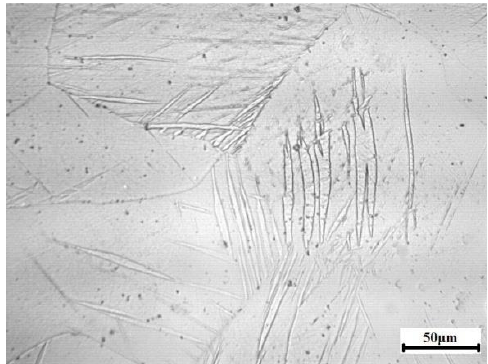
Figure 1. Optical microstructure characteristic of homogenized AZ31 magnesium alloy.